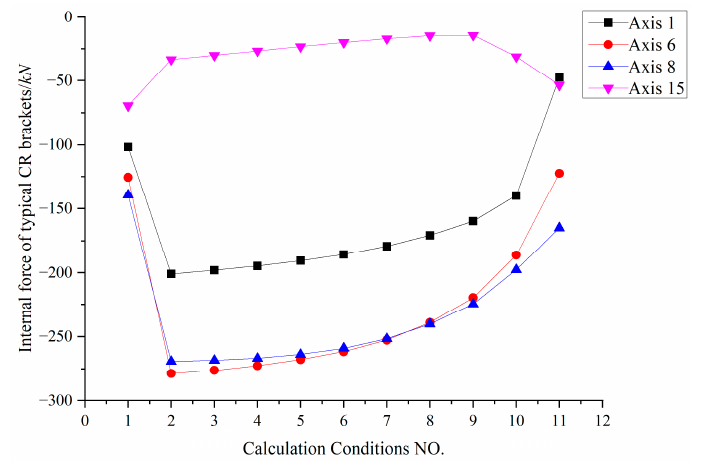
Figure 20. Schematic diagram of four groups of typical CR brackets.